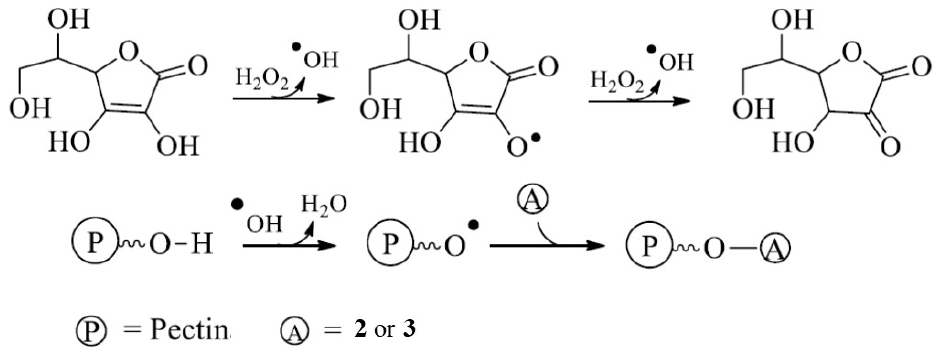
Figure 1. Schematic representation of the synthesis of the macromolecular conjugate.